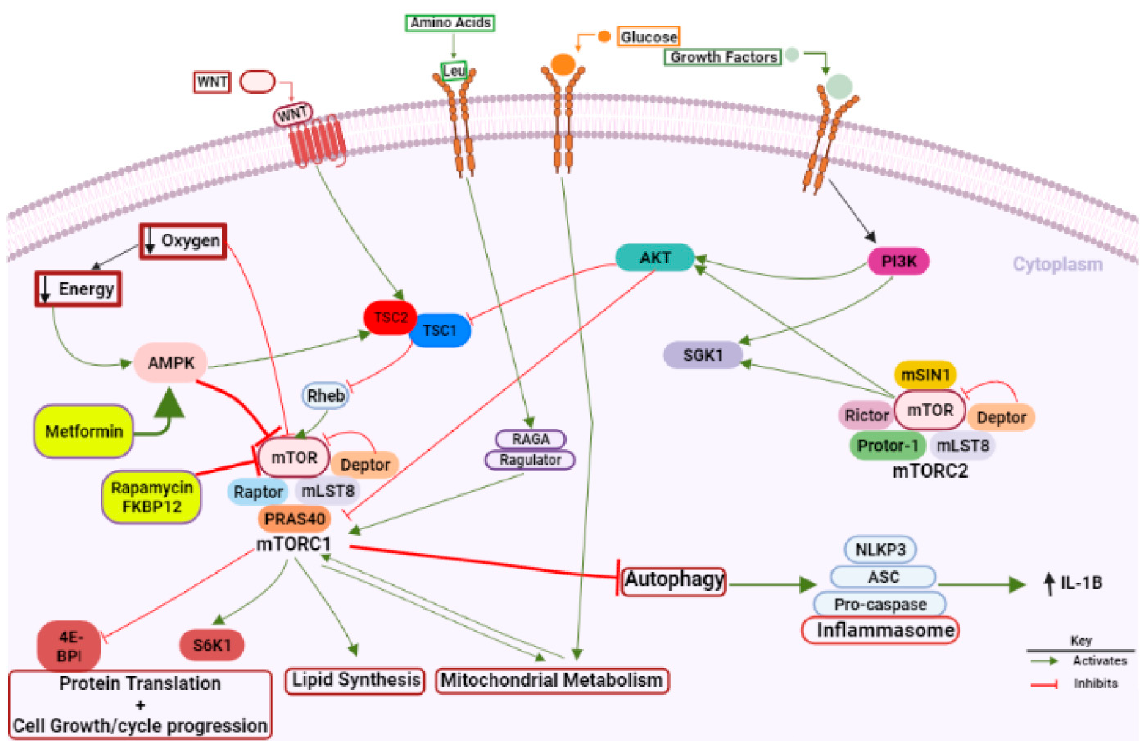
Figure 1. mTOR signaling pathway. mTOR is activated by the presence of growth factors, glucose, amino acids, WNT at the cell-surface, and by several intracellular clues. Signaling to mTORC1 is stimulated by growth factors, WNT via PI3K/AKT signaling. In an environment with sufficient nutrients, the autophagy process is negatively regulated by mTOR. AMPK activation, starvation, or hypoxia inhibit mTOR. Rapamycin, the inhibitor of mTOR, represses autophagy, and regulates inflammation. There is cross-talk between inflammasomes and autophagy to maintain homeostasis among the inflammatory response against pathogens and inhibition of disproportionate inflammation. During mTOR inhibition of autophagy, NLRP3 inflammasome activation is enhanced, and this effect is reversed after rapamycin treatment. Metformin enhances autophagy and inhibits NLRP3 inflammasome via AMPK/mTOR signaling inhibition. mTOR is implicated in several biological processes: protein translation, cell growth/cycle progression, lipid synthesis, and mitochondrial metabolism. Created with BioRender.com. 4EBP1: eukaryotic translation initiation factor 4E-binding protein 1; AMPK: AMP-activated protein kinase; ASC: C-terminal caspase recruitment domain; mTOR: mammalian target of rapamycin; NLRP3: nucleotide-binding oligomerization domain (NOD)-like receptor protein 3; RAG: regulator; RHEB: ras homolog enriched in brain; S6 Kinase 1: ribosomal protein S6 kinase beta-1; TSC: tuberous sclerosis complex. Figure created with BioRender.com (last accessed on 16 July 2022).